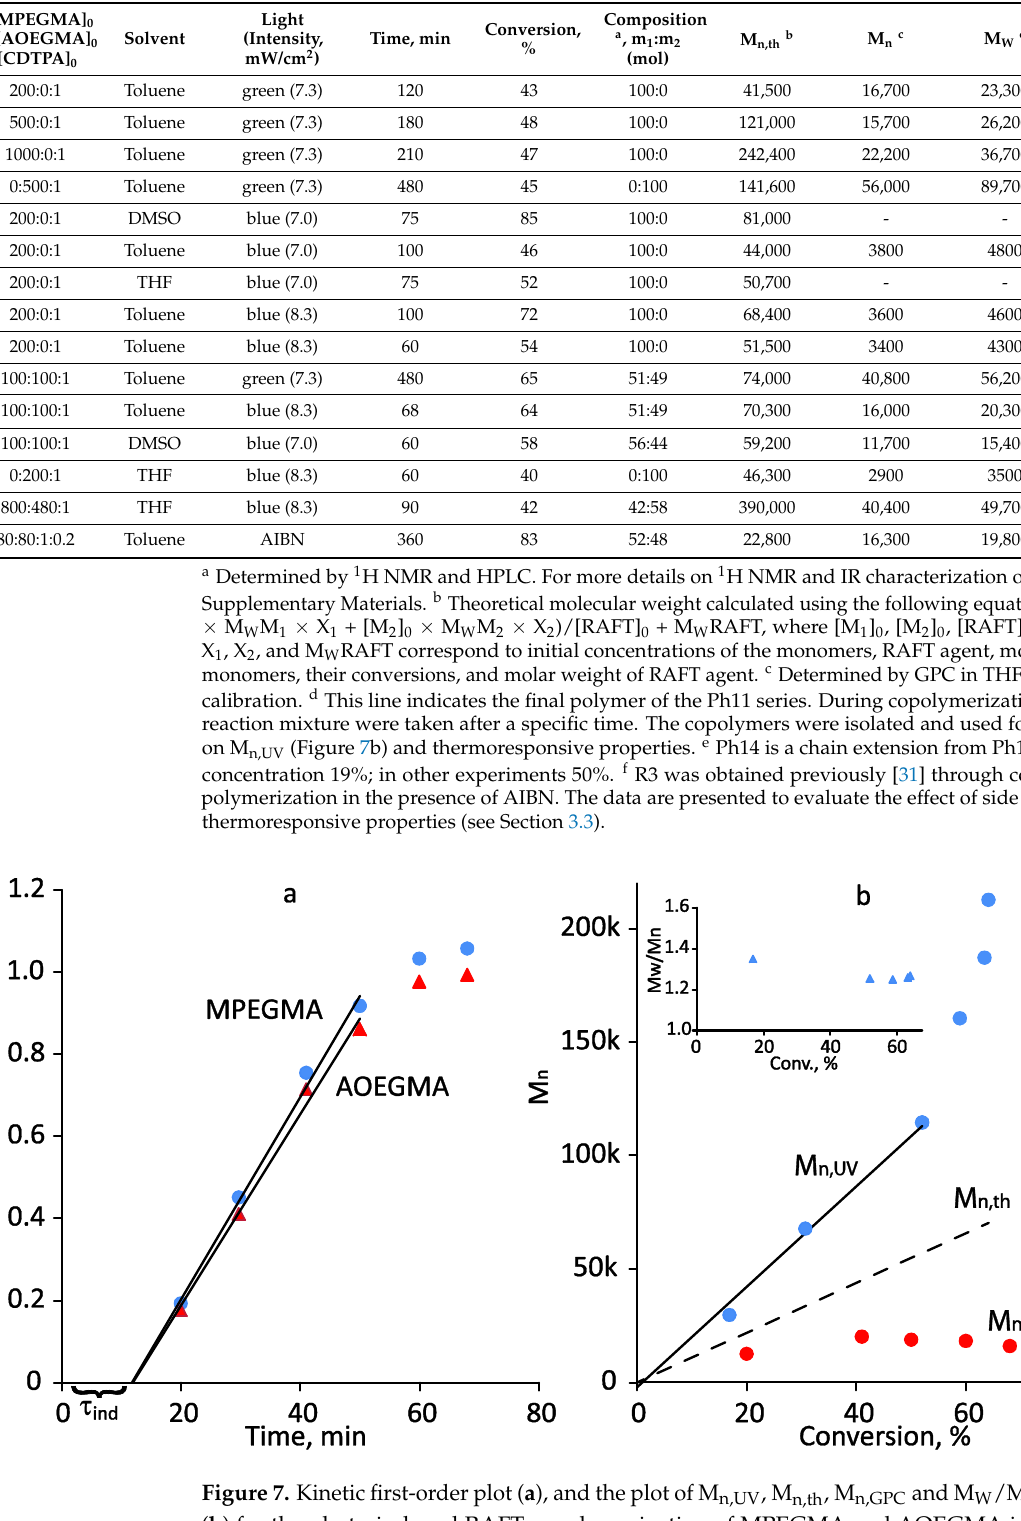
Figure 8. Kinetic first-order plot ( a ), and the plot of M n,th , M n,GPC ( b ) and M W /M n ( c ) vs. conversion for the photo-induced RAFT polymerization of MMA and LMA in DMSO. Polymerization conditions: ω monomer = 50 wt.%, [Monomer] 0 /[CDTPA] 0 = 200:1, green LED, 7.3 mW/cm 2 , 35 °C. Figure 9 shows the spectra of MPEGMA–AOEGMA copolymers isolated at different conversions; the corresponding M n,UV values calculated according to [42] are shown in Figure 7b. A linear dependence up to a conversion of ~55% was also observed in this case. The higher M n,UV values compared to M n,th can be explained by the presence of small amounts of dimethacrylates (formed during macromonomer production and which are difficult to remove) leading to rare cross-links. At high conversions, irreversible chain termination reactions could obviously take place.